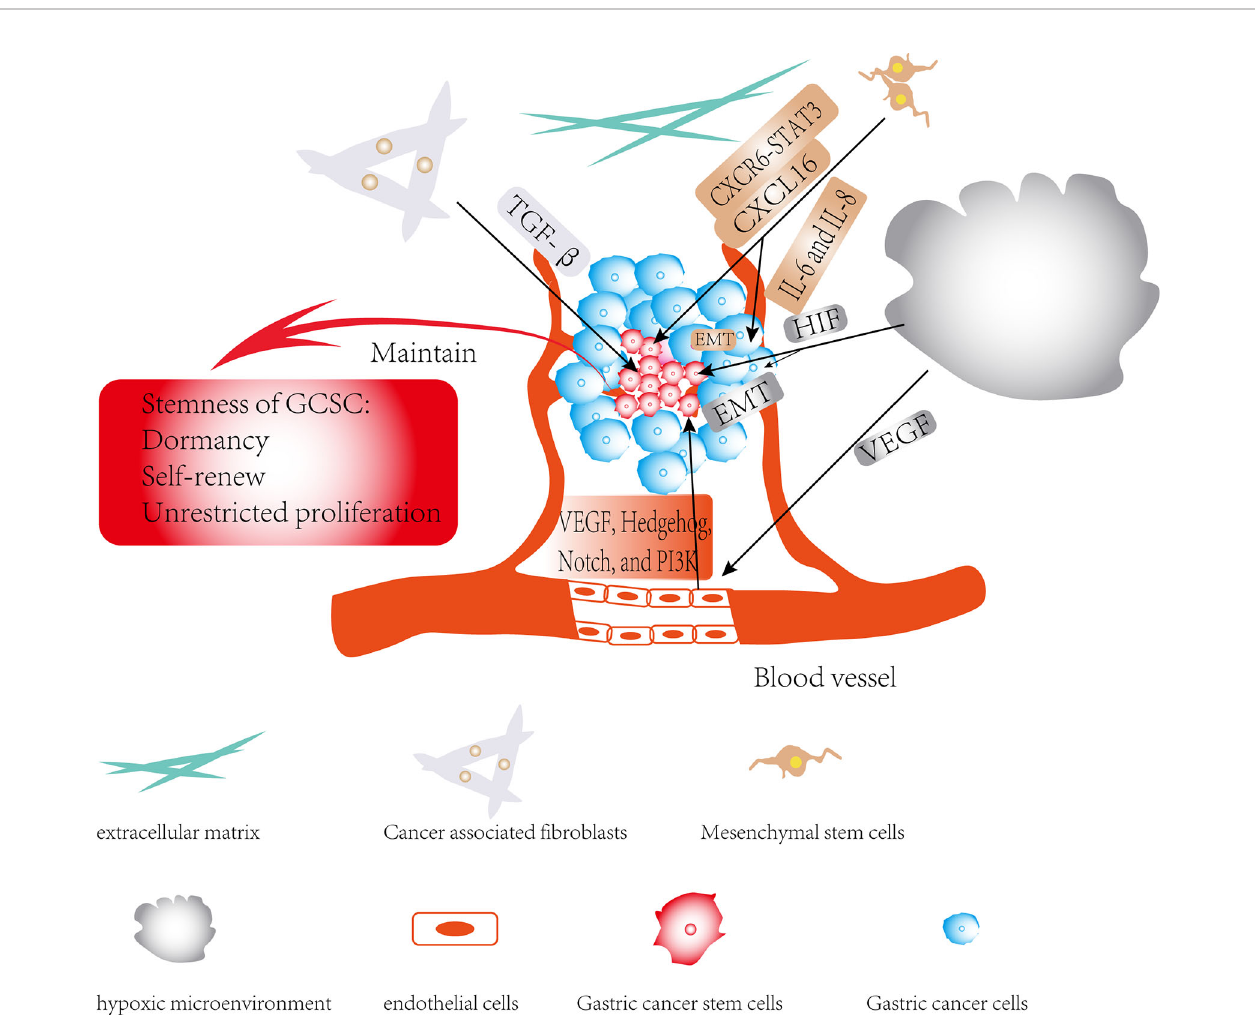
FIGURE 3 | Regulatory role of TME in gastric cancer stem cells (GCSCs): The effects of members of the TME on GCSCs are shown by black arrows; the role of TME in maintaining the stemness of GCSCs is shown by red